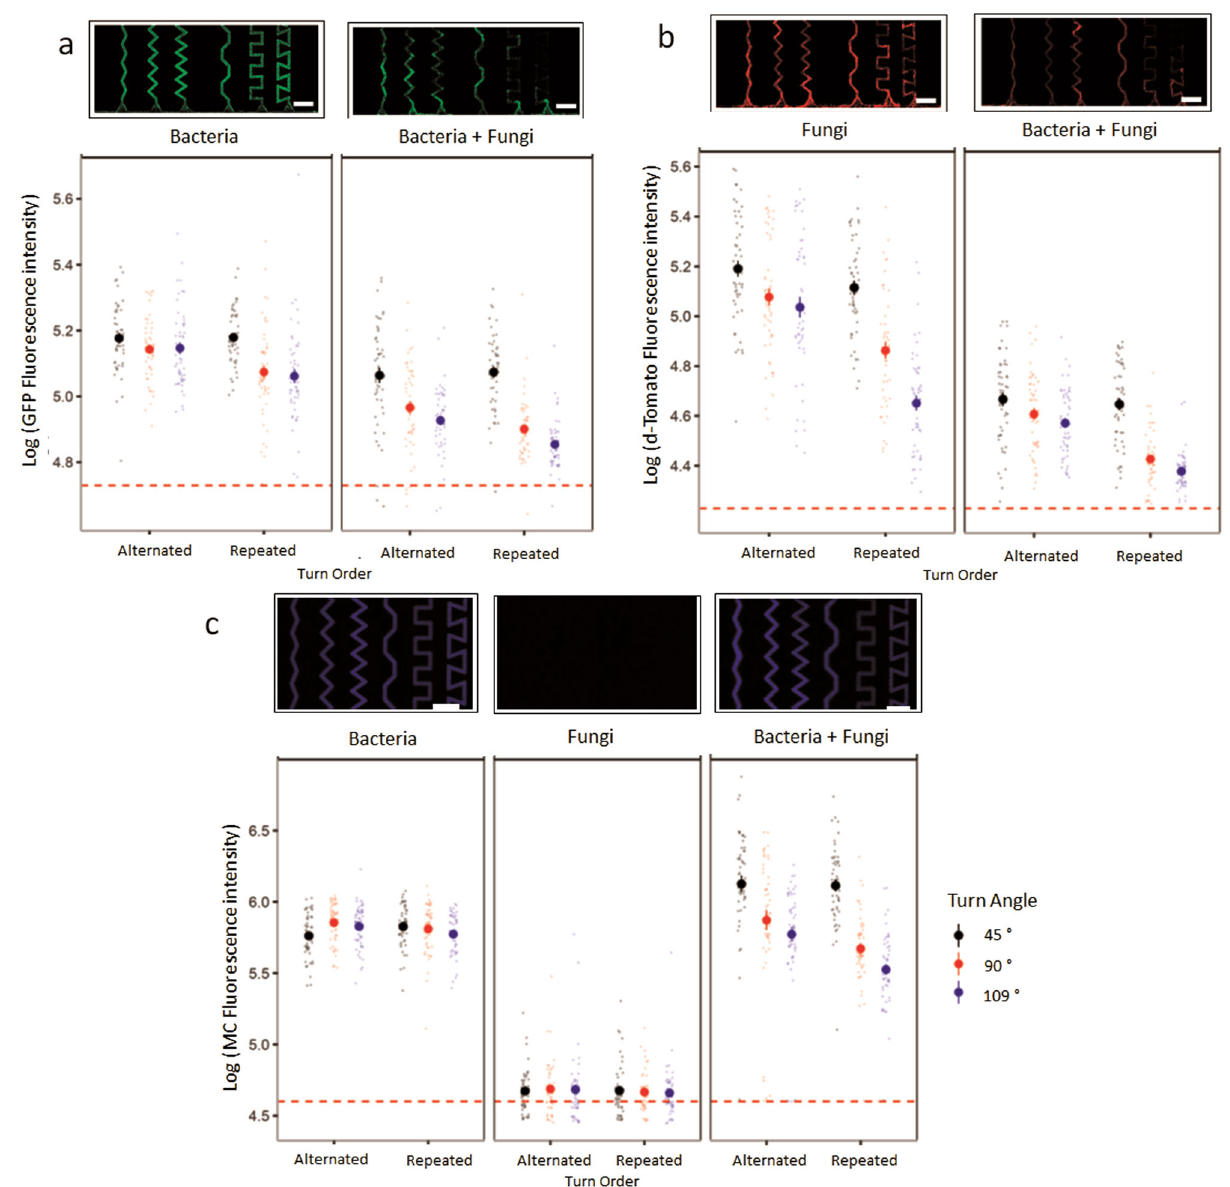
Fig. 2 Bacterial and fungal biomass and their substrate consumption in differently angled channels. a Upper pannels show examples of the initial part of the micro fl uidic channels colonized by P . putida expressing GFP constitutively inside the micro fl uidic chip, on day 2 after inoculation, growing without (left) and with (right) the competitor C. cinerea (scale bar = 100 µ m). Bottom panels show the three-way analysis of the response of bacterial biomass to the different channel types at day 2, in the absence (left) and in the presence (right) of the fungal competitor C. cinerea , as quanti fi ed via bacterial GFP fl uorescence expression. b Upper pannels show examples of the initial part of the micro fl uidic channels colonized by C.cinerea expressing d-Tomato constitutively, on day 6 after inoculation, growing in the absence (left) and the presence (right) of the competitor P. putida . Below shows the three-way analysis plot of the d-Tomato fl uorescence intensity of C. cinerea inside the channels on day 6, without (left) and with (right) the competitor P. putida . c Upper panels show the substrate consumption represented by fl uorescence of released 4-methylcoumarin in the initial part of the micro fl uidic channels, at day 6 after inoculation with the bacterial strain P. Putida ( “ bacteria ” ), the fungal strain C. cinerea ( ” fungi ” ), and the combined experiment containing P. putida and C. cinerea ( “ bacteria + fungi ” ; Scale bars = 100 µ m). The circles represent the mean log-transformed fl uorescence of the respective fl uorophore for each treatment and the error bars represent the ± SE based on ANOVA for all the channel types ( n = 50). The dots correspond to each fl uorescence measurement inside each type of channel. Color coding of dots and circles represent the angle of the channels, being black for 45°, red for 90°, and blue for 109°. The dashed red line represents the mean background fl uorescence for each type of fl uorescence